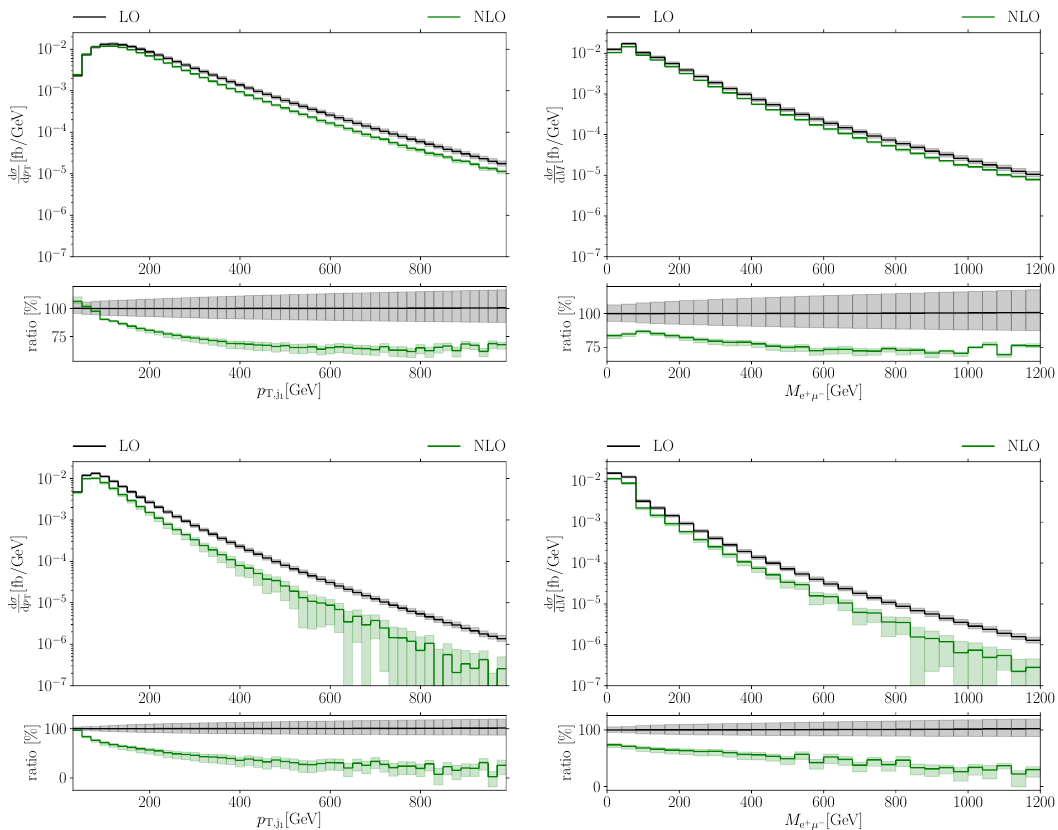
Figure 12. Differential distributions at LO and NLO in the transverse momentum of the leading jet (left) and the invariant mass of the charged-lepton pair (right) in the VBS setup (top) and the Higgs setup (bottom). The upper panels show the absolute EW contribution at NLO contribution bands indicate the 7-point scale